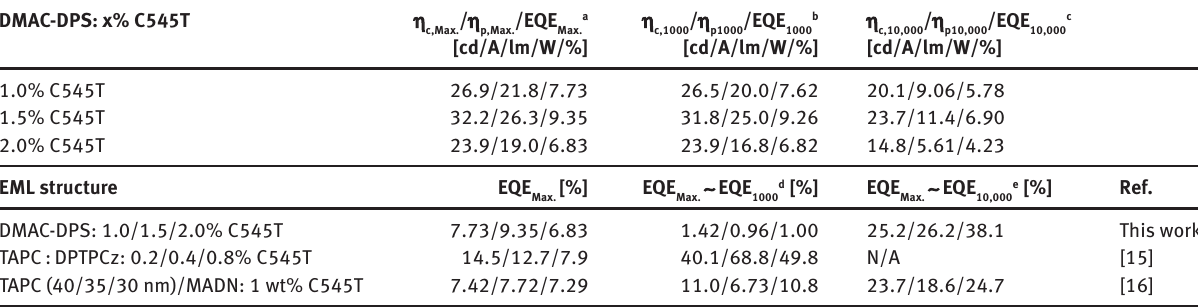
Table 1: Summary EL performance and roll-off ratio of the Fl-OLEDs in this paper with representative devices based on C545T. DMAC-DPS: x% C545T